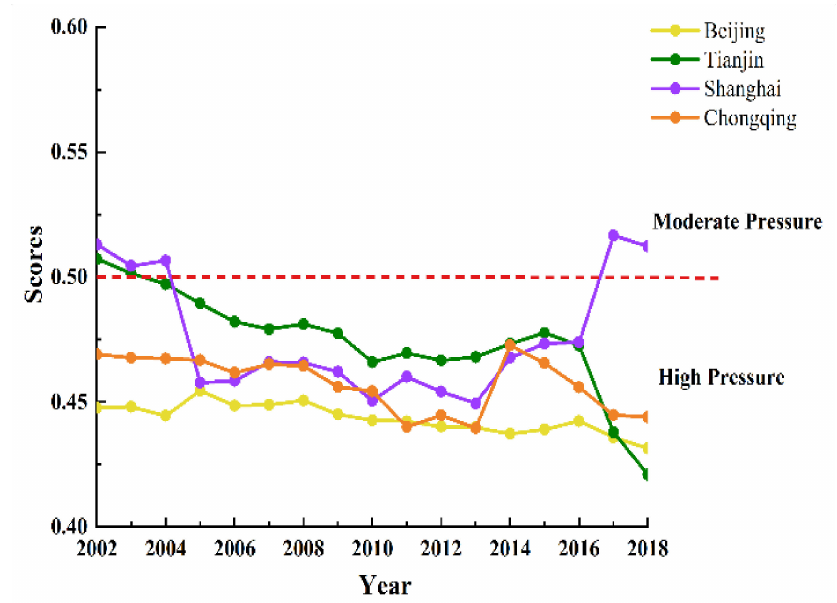
Figure 3. Trends in pressure resilience from 2002 to